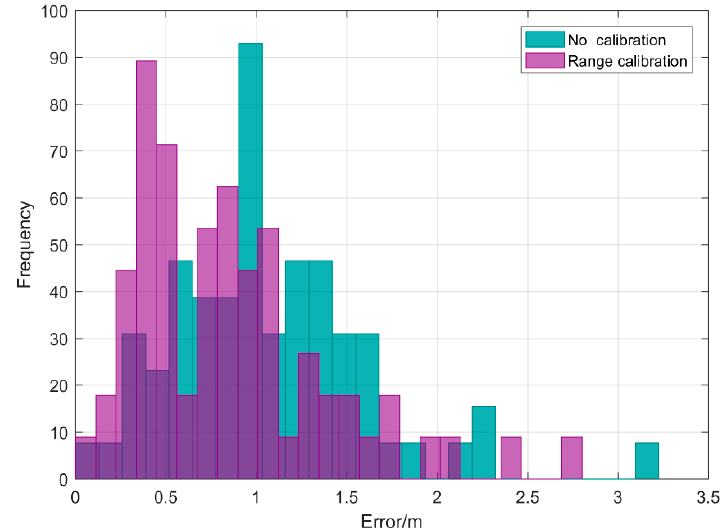
Figure 9. The positioning effect of no calibration and range calibration.